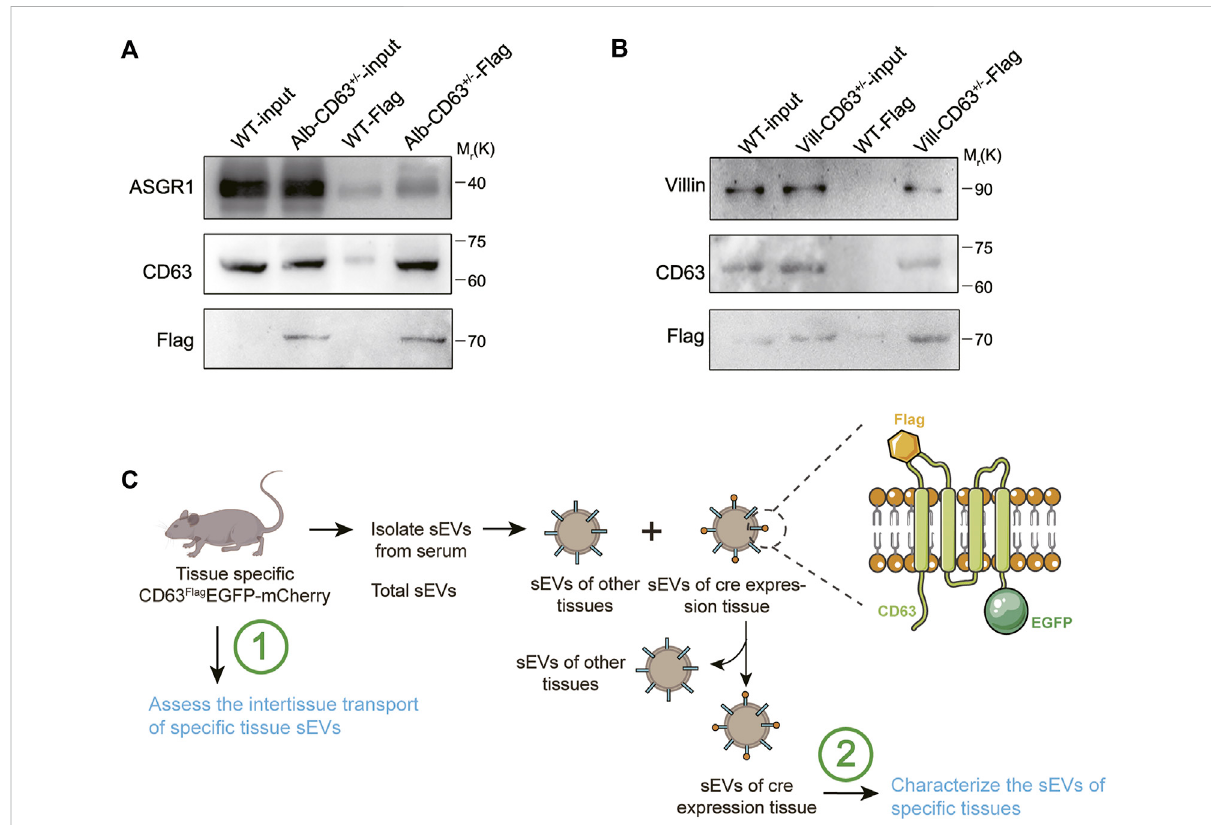
FIGURE 6 Western blot analysis of serum sEVs immunoprecipitated with anti-Flag antibody. (A) Representative western blot results of ASGR1 (hepatic-EV speci fi c protein), CD63 and Flag via fl ag-speci fi c immunoprecipitation from both wild-type and alb-CD63 Flag EGFP-mCherry mouse serum EVs. (B) Representative westernblotresultsofvillin(intestinespeci fi cprotein),CD63andFlag via fl ag-speci fi cimmunoprecipitationfrombothwild-type and villin-CD63 Flag EGFP-mCherry mouse serum EVs. (C) Schematic representation of sEVs from tissue speci fi c CD63 Flag EGFP-mCherry mouse isolated for